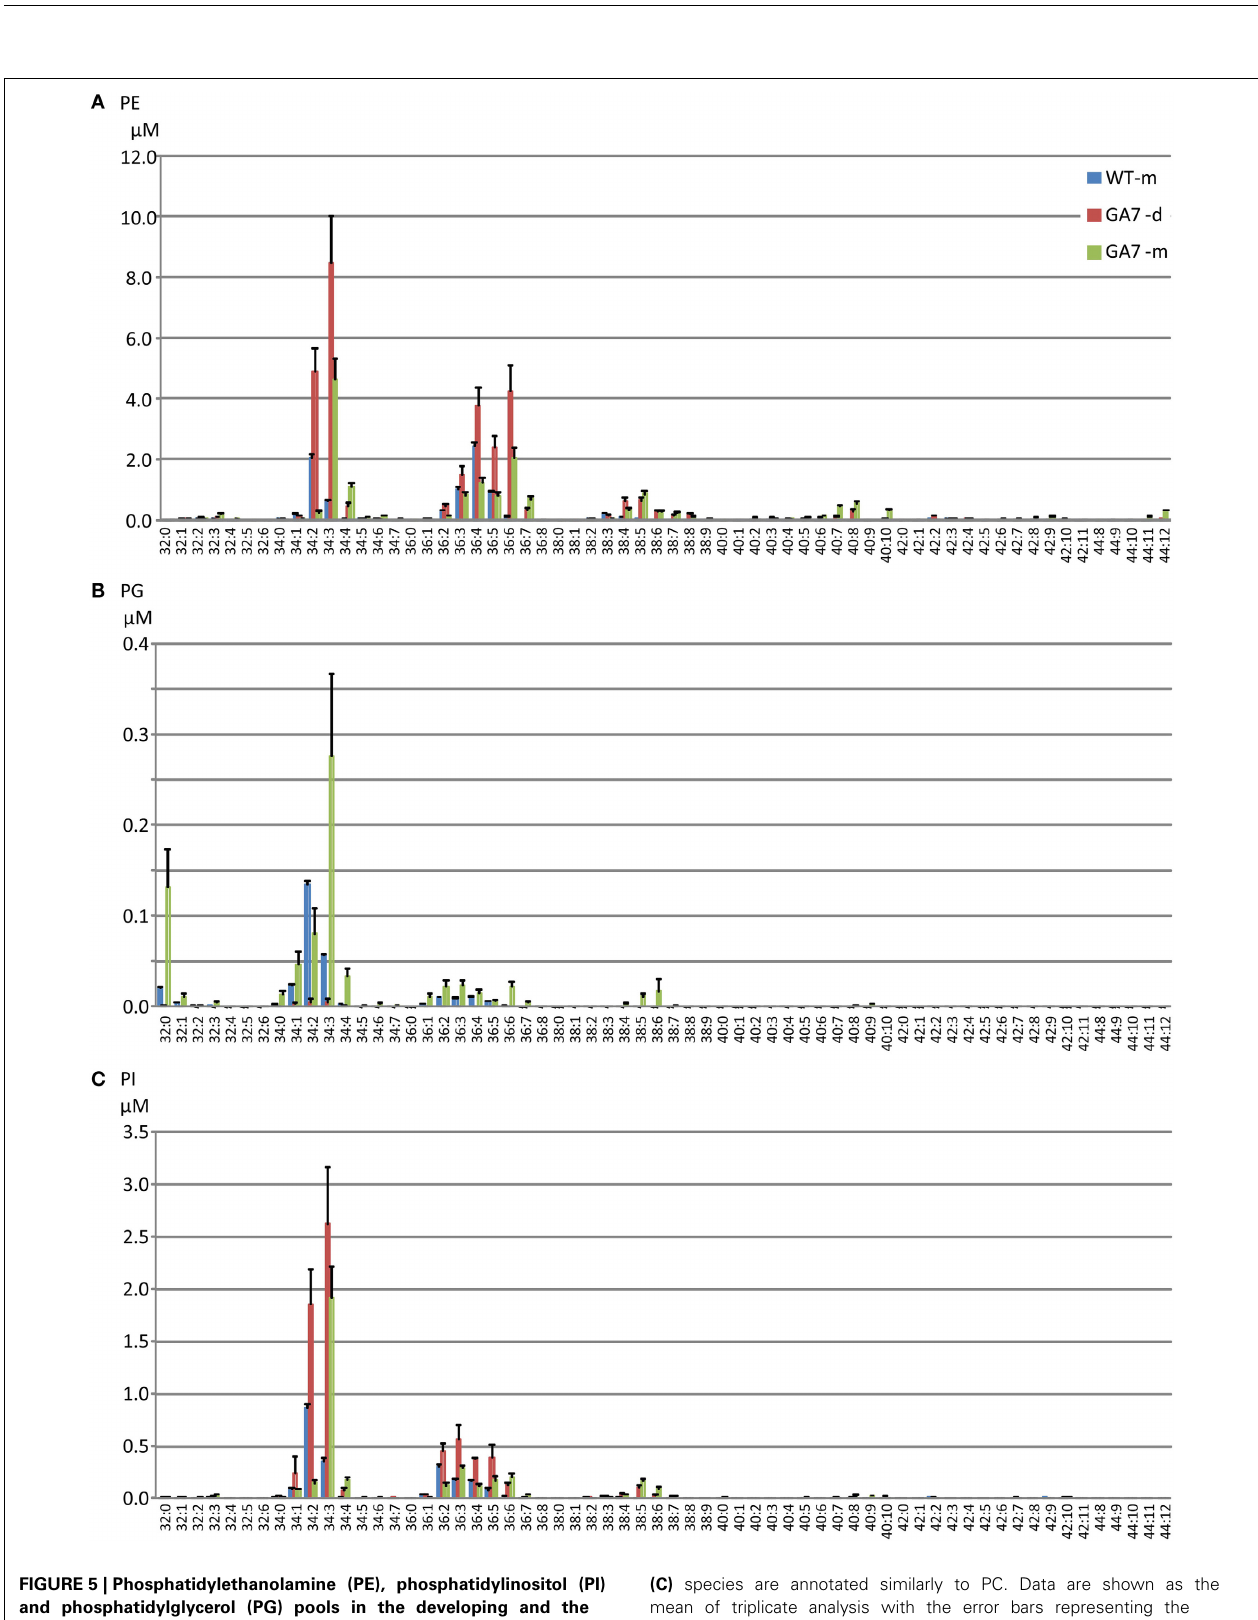
(C) species are annotated similarly to PC. Data are shown as the mean of triplicate analysis with the error bars representing the standard